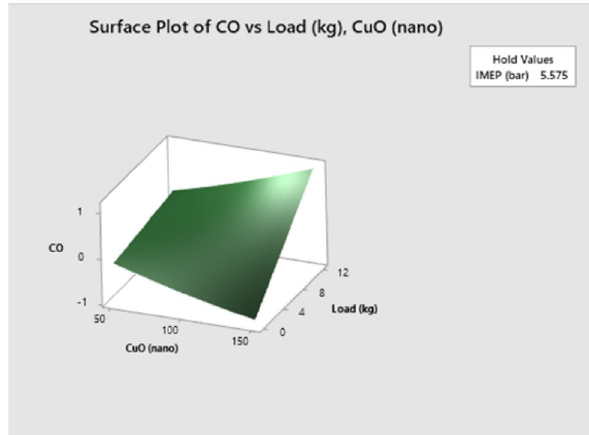
Fig. 24 Contour plot of CO without nanoparticles